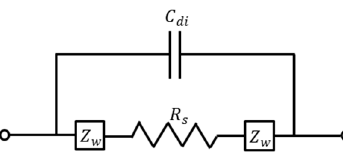
Figure 5. Circuit model of impedance measurement for electrolytic solution.